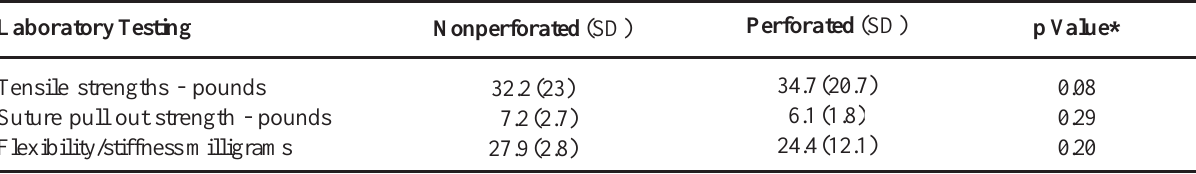
Table 2 – Results of tensile strength, pull out strength, and flexibility testing of perforated and nonperforated porcine dermal grafts.